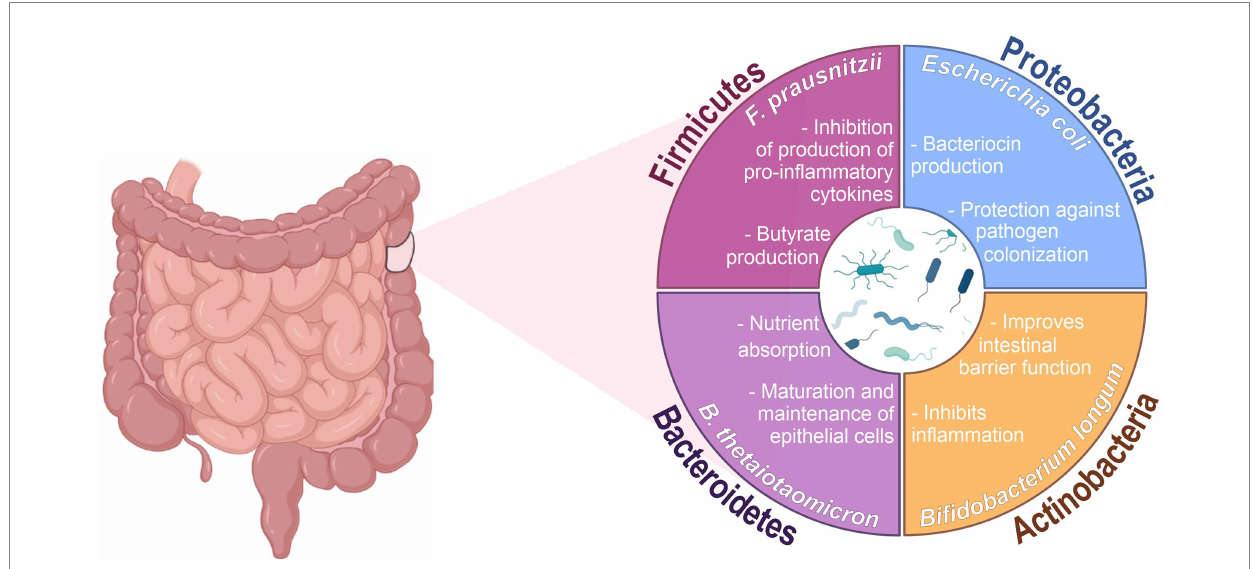
FIGURE 1 Main phyla and functions associated with the intestinal microbiota. Created with BioRender.com and